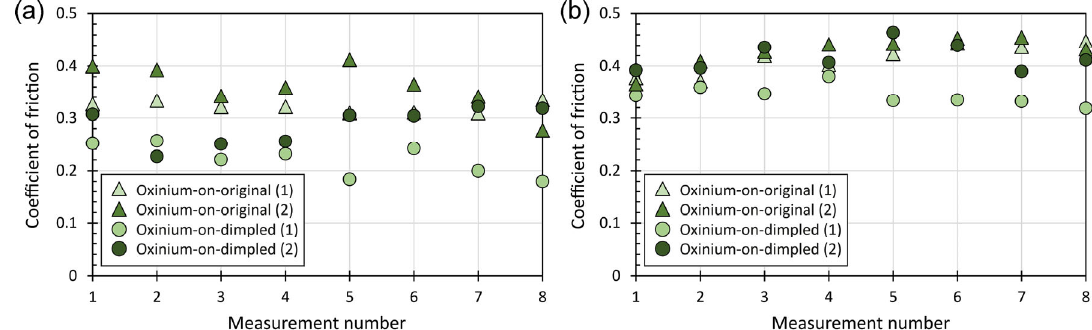
∣ www.Springer.com/journal/40544 | Friction http://friction.tsinghuajournals.com